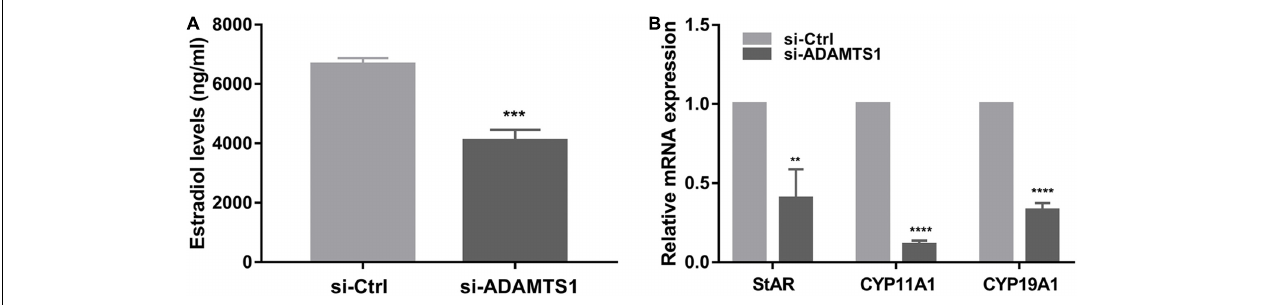
FIGURE 3 | Down-regulation of ADAMTS1 inhibits estradiol secretion in granulosa cell. The E 2 secretion in primary granulosa cells after silencing of ADAMTS1 using 50 nM si-ADAMTS1 for 48 h (A) . Real-time PCR analysis of the expression of StAR, CYP11A1 and CYP19A1 in primary granulosa cells after silencing of ADAMTS1 by 50 nM si-ADAMTS1 for 48 h (B) . GAPDH gene was used as an internal control. ** Indicates p < 0.01, *** indicates p < 0.001, and **** indicates p < 0.0001.